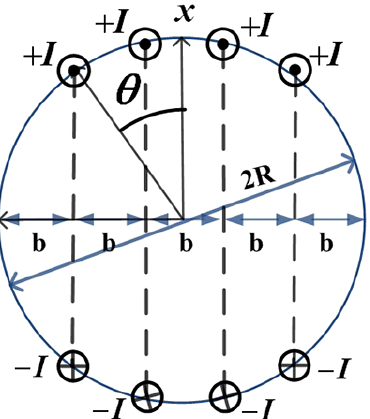
Figure 4. Bolinger’s coil: the turns, distributed along the circum- ference (placed around the cylinder at angles θ (NB the comple- mentary angle (cid:56) was used in Bolinger’s paper)), are equally spaced projected along the diameter ( b = 2 R/ (2 N +